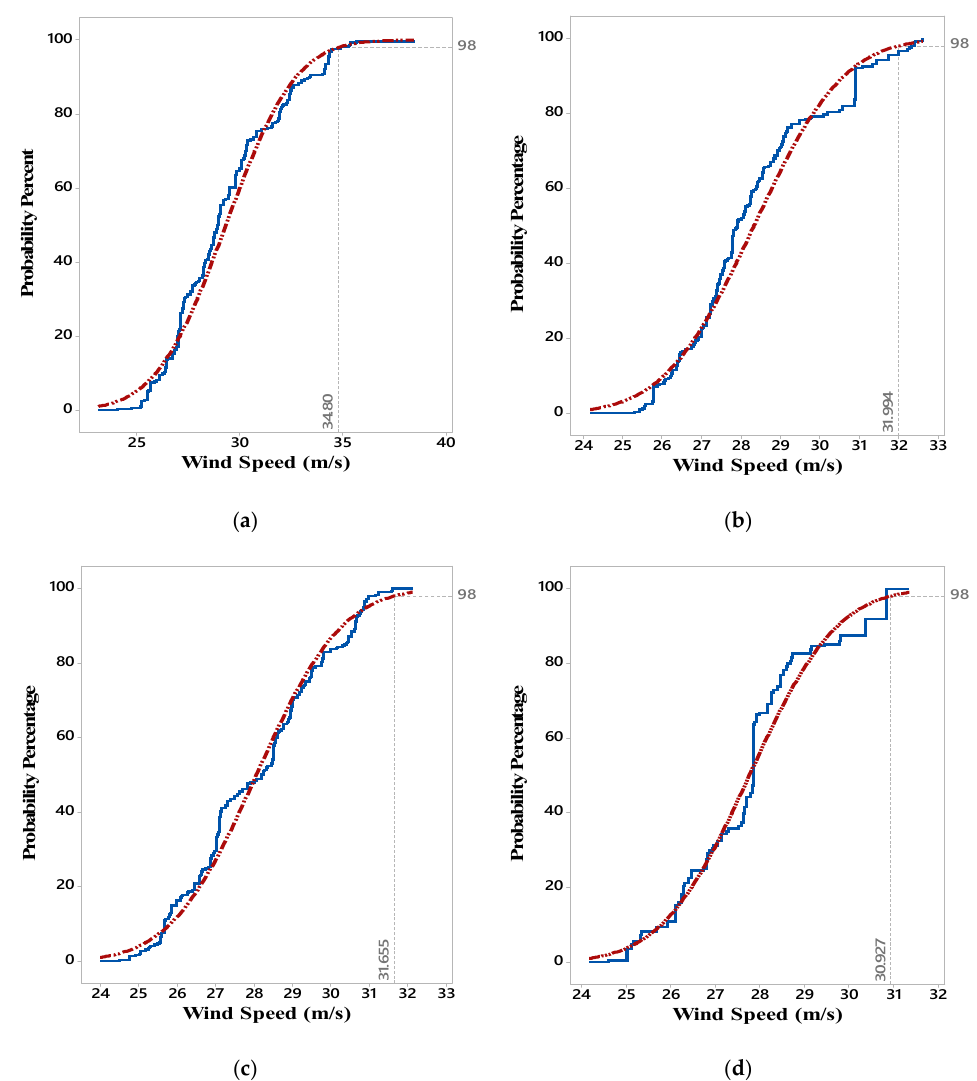
Figure 12. Cumulative Distribution Function (CDF) analysis of Peninsular Malaysia ( a ) V site ; ( b ) V mukim ; ( c ) V s ; ( d ) V District .